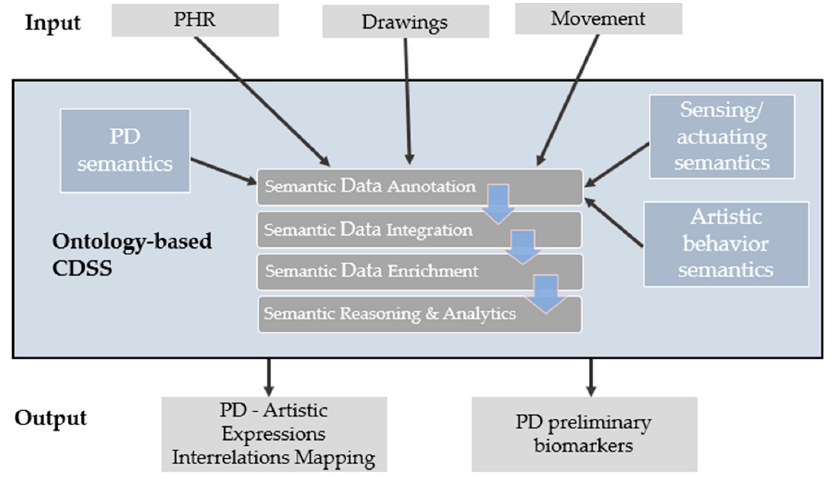
Figure 4. High ‐ level design of a system realizing the proposed framework for PD patients . Figure 4. High-level design of a system realizing the proposed framework for PD